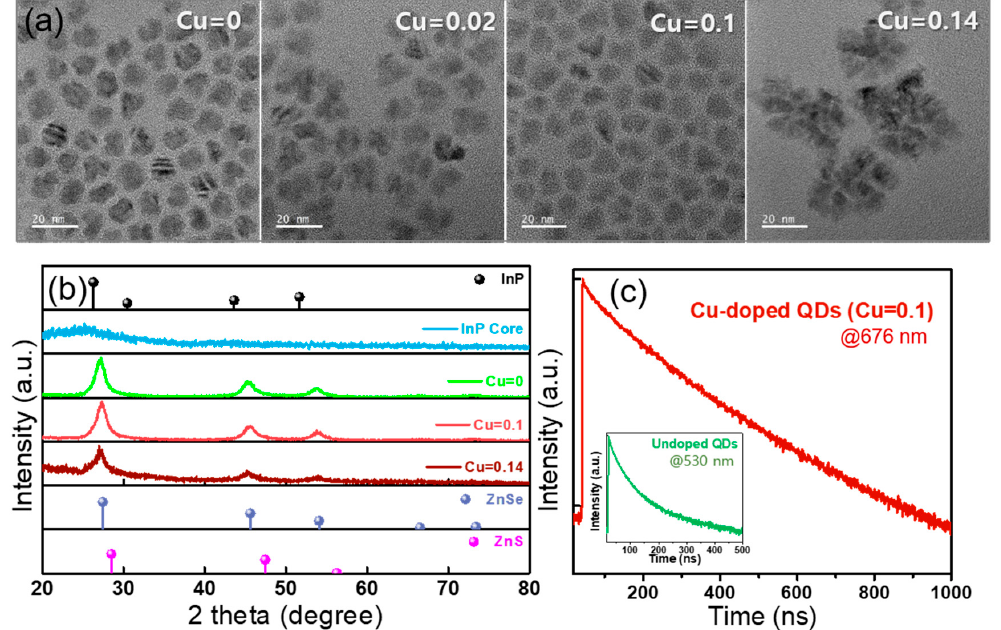
Figure 2. ( a ) TEM images of undoped and Cu-doped InP / ZnSe / ZnS QDs with 0.02, 0.1, and 0.14 Cu mole fraction. The scale bars are 20 nm for all; ( b ) XRD patterns of pure InP core, undoped and Cu-doped InP / ZnSe / ZnS QDs with 0.1 and 0.14 Cu mole fraction; ( c ) PL decay profiles of Cu-doped InP / ZnSe / ZnS QDs with 0.1 mole fraction and undoped QDs (inset) with detected wavelengths of 676 and 530 nm, respectively.